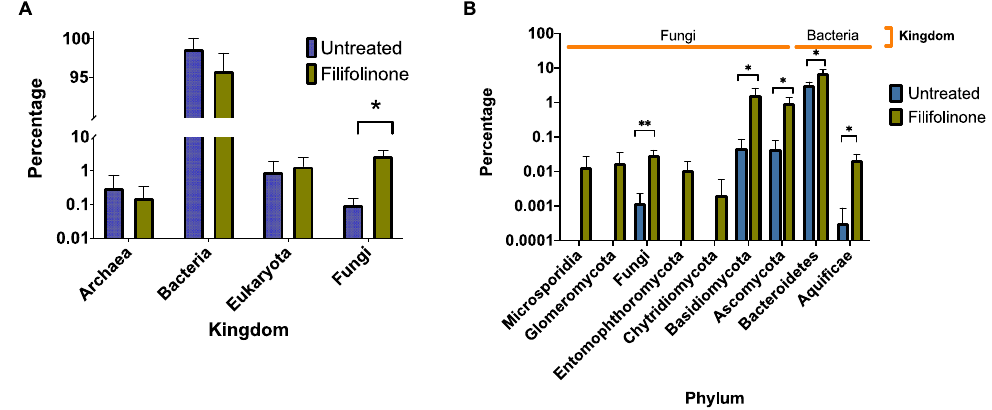
Figure 8. Effect of filifolinone on the composition of the Atlantic salmon gut microbiota. The figure shows the effect of intramuscular injection of filifolinone on the microbiotic composition in the gut epithelia of Atlantic salmon. Microbiota was evaluated by 16S rRNA sequencing of the V3–V4 region using samples of total DNA from gut epithelia. The figure shows ( A ) Kingdoms that had statistically significant changes in abundance; and ( B ) Phyla belonging to the Kingdoms Bacteria and Fungi with statistically significant differences in abundance. Statistical significance was determined by a t -test (* p < 0.05, ** p < 0.01).